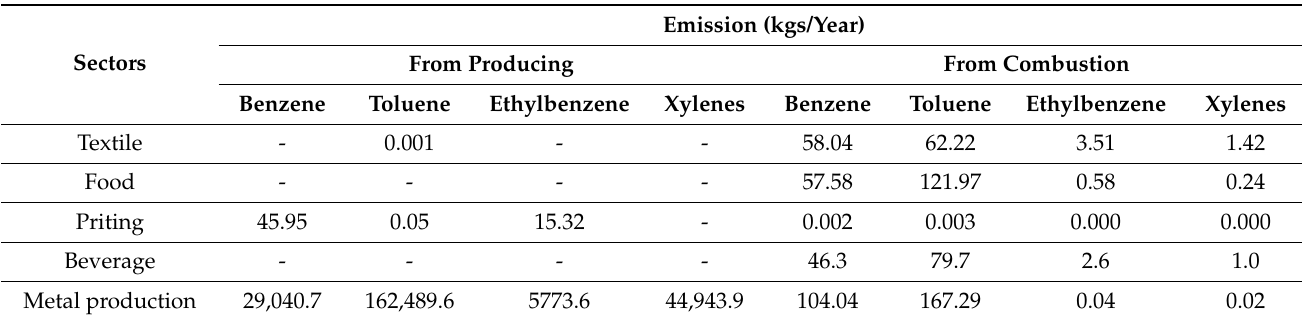
Table 4. BTEX emission (kgs/year) from producing and combustion activities of five primary industrial sectors in Ho Chi Minh City.